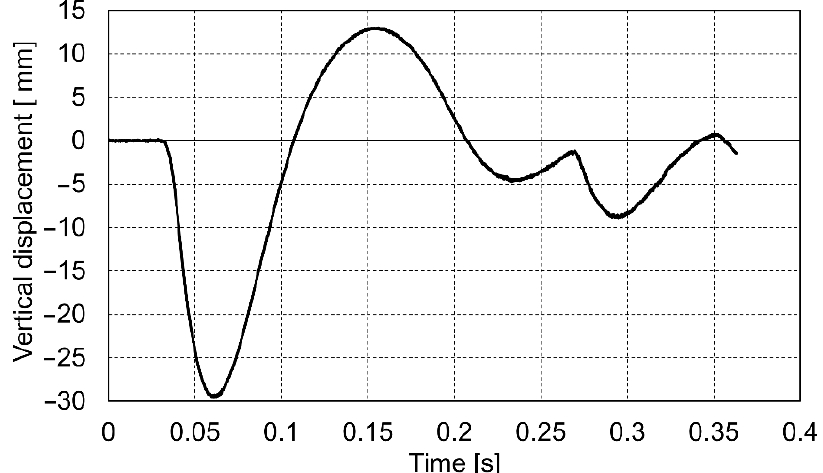
Figure 9. Vertical displacement of the p0 point during drop No. 1.